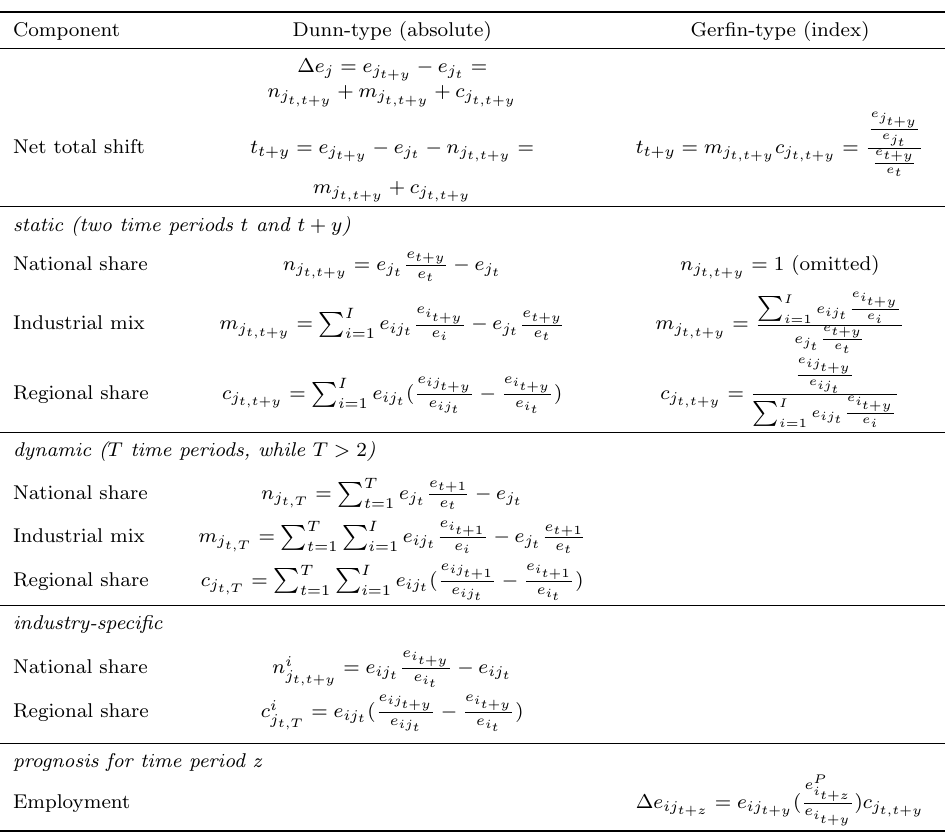
Table 12: Shift-share analysis: Dunn and Gerfin